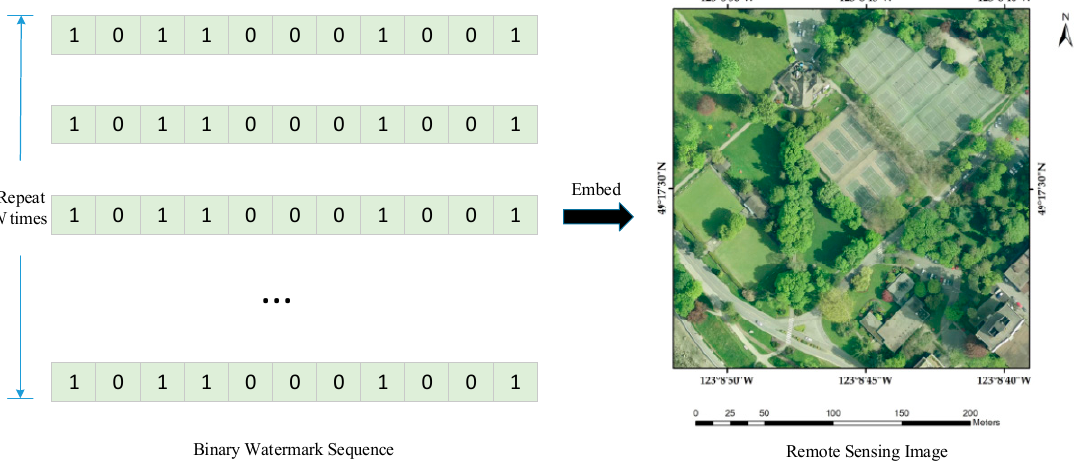
Figure 3. Illustration of Principle 1.